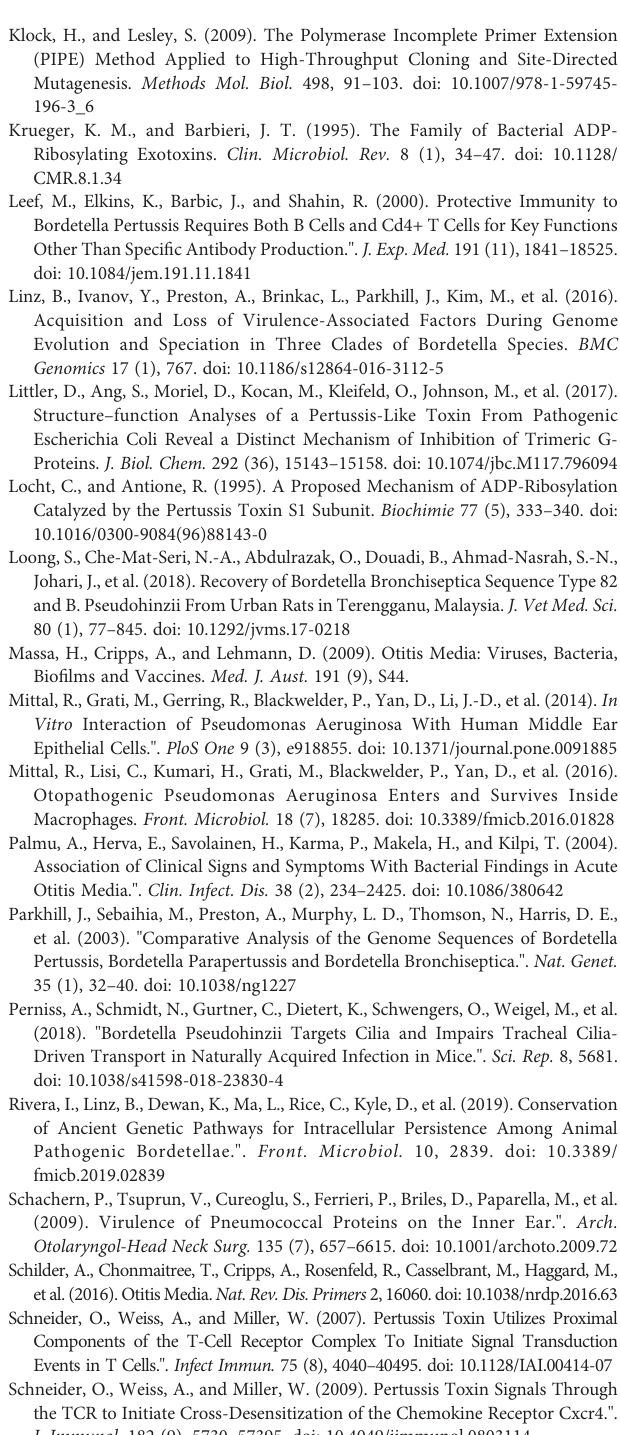
PBS. There are three replicates per group. Statistical signi fi cance was calculated using Unpaired t-test. *p<0.05, **p<0.01, ***p<0.001, n.s. >0.05. Supplementary Table 1 | B. pseudohinzii and B. pertussis protein homology. Comparison of amino acid sequences of PSx ( B. pseudohinzii ) and PTx ( B. pertussis ) toxin subunits and Type IV secretion system